Question: Give a one-sentence summary of this figure.
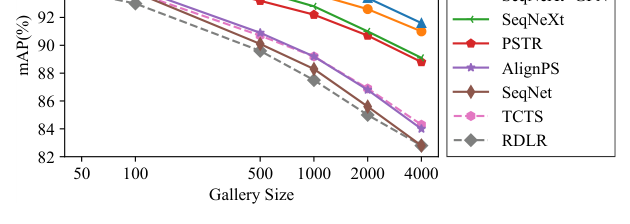
Answer: Comparison of mAP on CUHK-SYSU across various gallery sizes. The solid lines represent end-to-end methods and the dashed lines represent two-step methods.